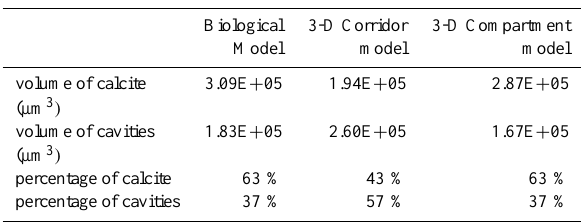
Table 2. Percentage volumes of calcite and cavities in the biological model, the corridor and the compartment